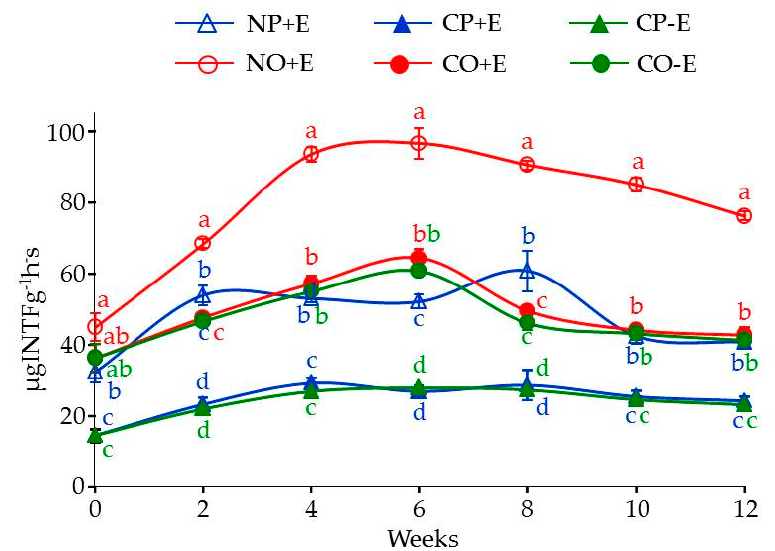
Figure 3. Dehydrogenase activity during the vermiremediation process. Error bars represent the standard deviation (n = 3). Different letters indicate significant differences between biomixtures ( p < 0.05) at each vermiremediation time.